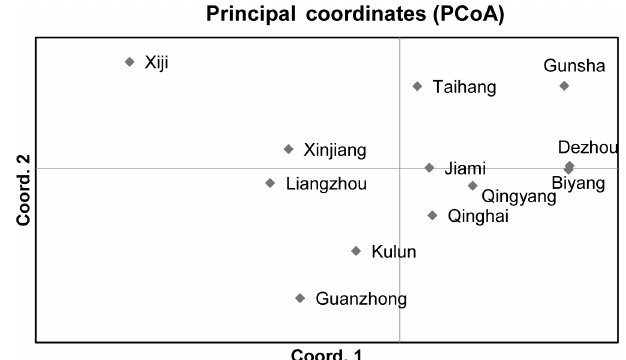
Figure 2. Principal coordinates analysis (PCoA) of 12 Chinese in- digenous donkey